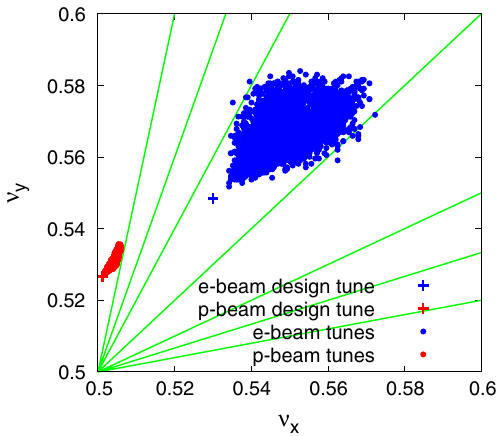
FIG. 5. Tune footprint for 4000 randomly selected representa- tive particles from each beam for the near-optimal working point denoted by a blue (cid:5) in Fig. 4, corresponding to ð (cid:3) x ; (cid:3) y Þ ¼ ð 0 : 53 ; 0 : 548 Þ for the electron beam and (0.501, 0.527) for the proton beam. The electron beam is shown in blue, and the proton in red. The location of the near-optimal working point is denoted with two crosses, one for each tune.